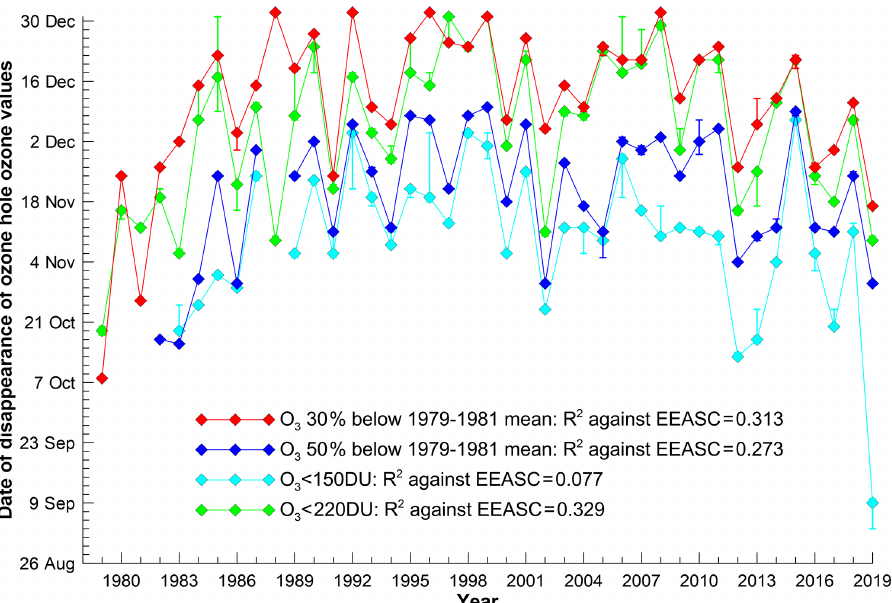
Figure 4. The annual dates of disappearance of ozone hole type values for all four threshold criteria. In some years the threshold for being identified as an ozone hole type value is not reached. The R 2 values show the correlation coefficient between each of the time series and EEASC for the years when disappearance dates are